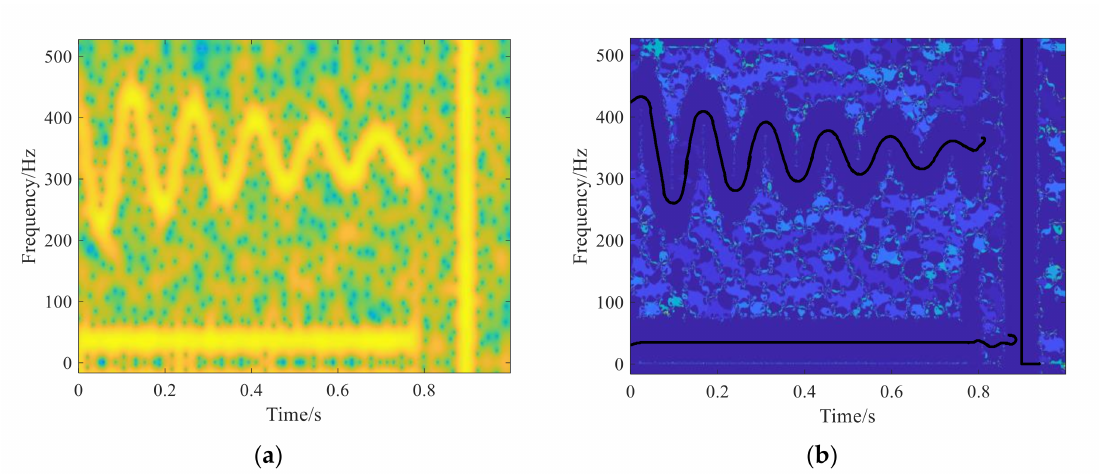
Figure 2. The researched numerical simulation signal. ( a ) Numerical signal shown in time-domain. ( b ) Numerical signal shown in frequency-domain.